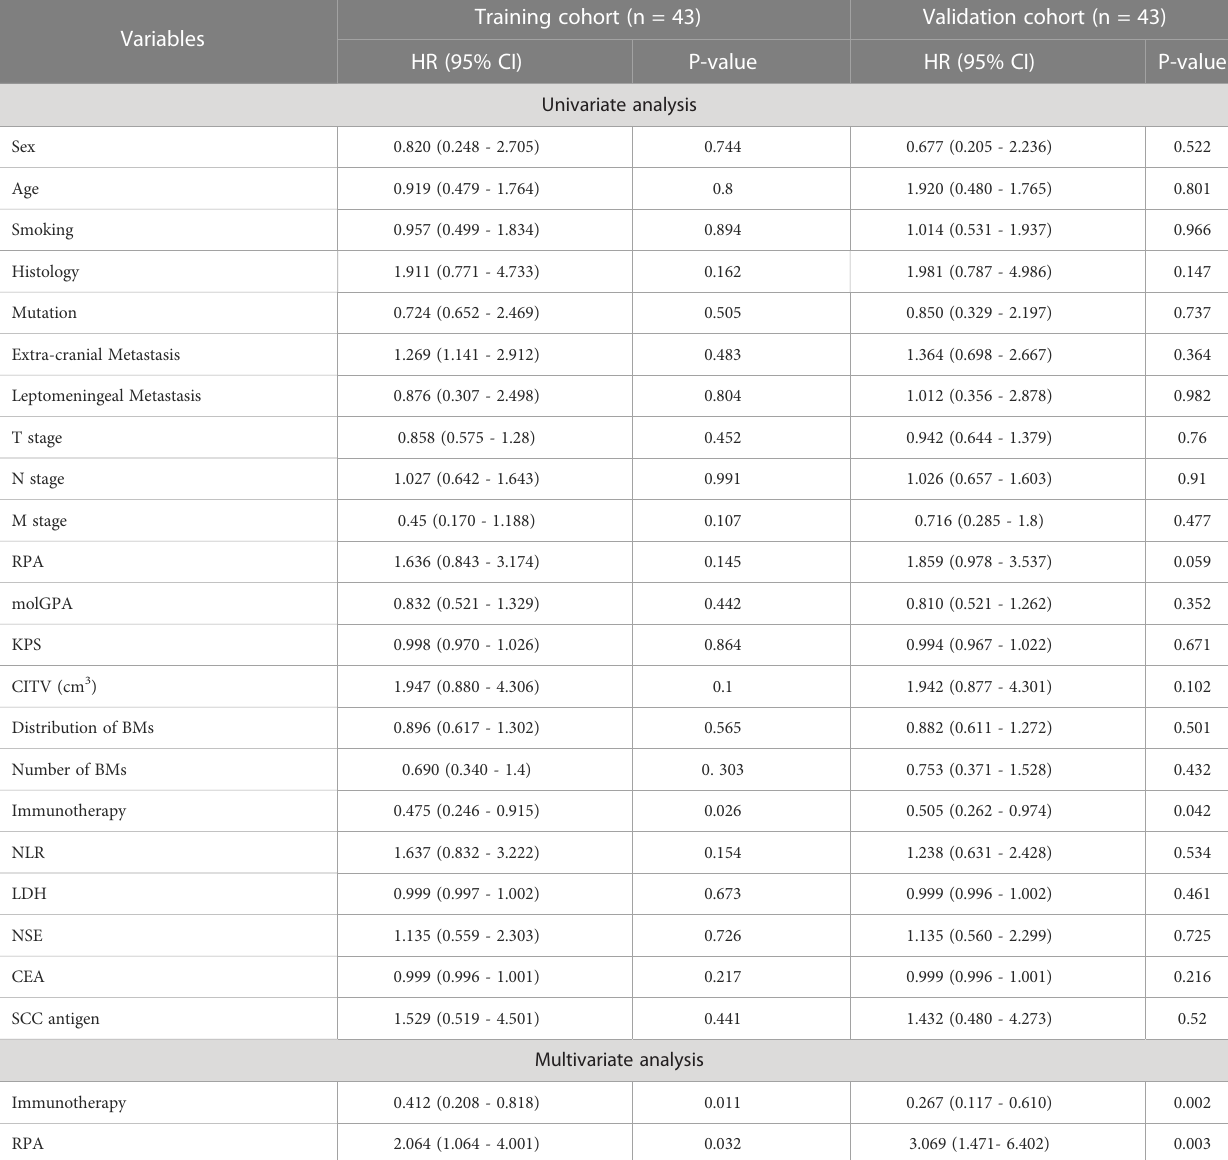
TABLE 5 Univariate and multivariate analysis for overall